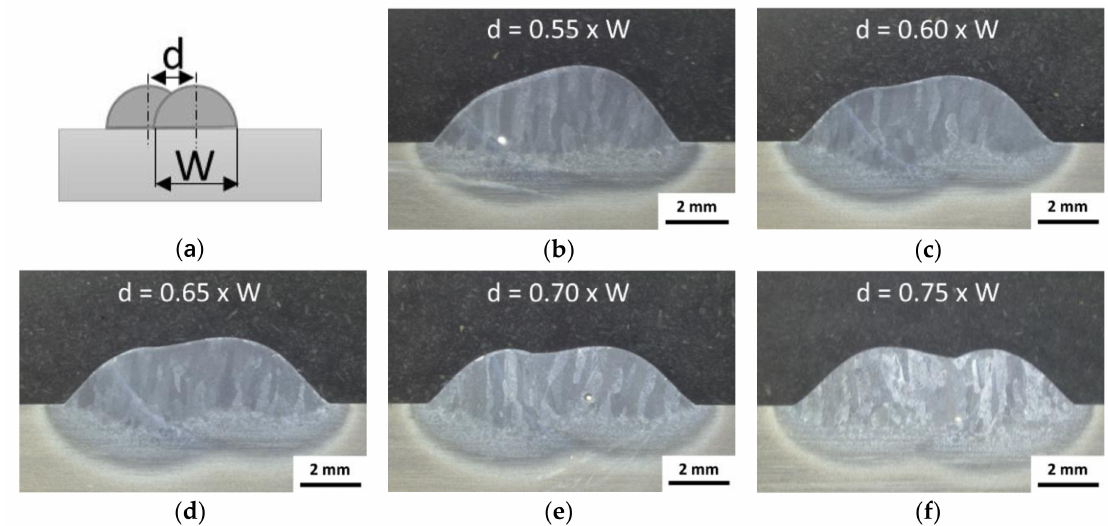
Figure 4. Multi-track overlapping distances (ratio d / W): ( a ) scheme of the overlapping with the main parameters d and W, ( b ) 0.55, ( c ) 0.60, ( d ) 0.65, ( e ) 0.70, and ( f )